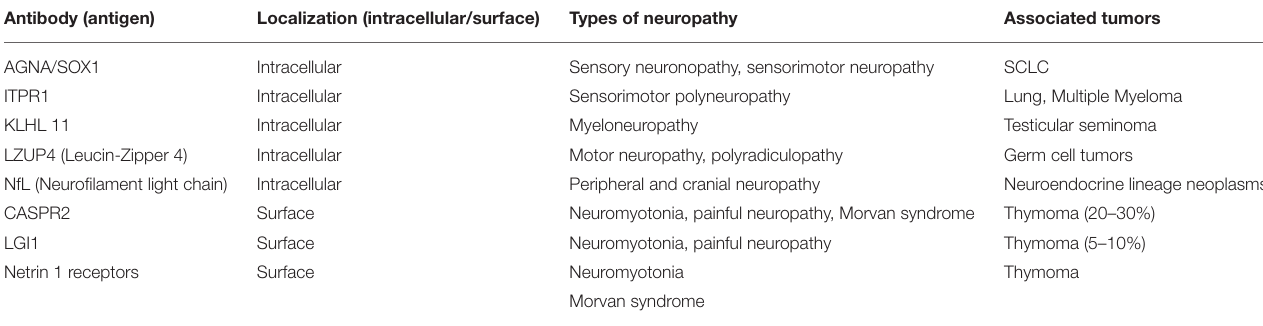
TABLE 3 | Novel antibodies associated with paraneoplastic